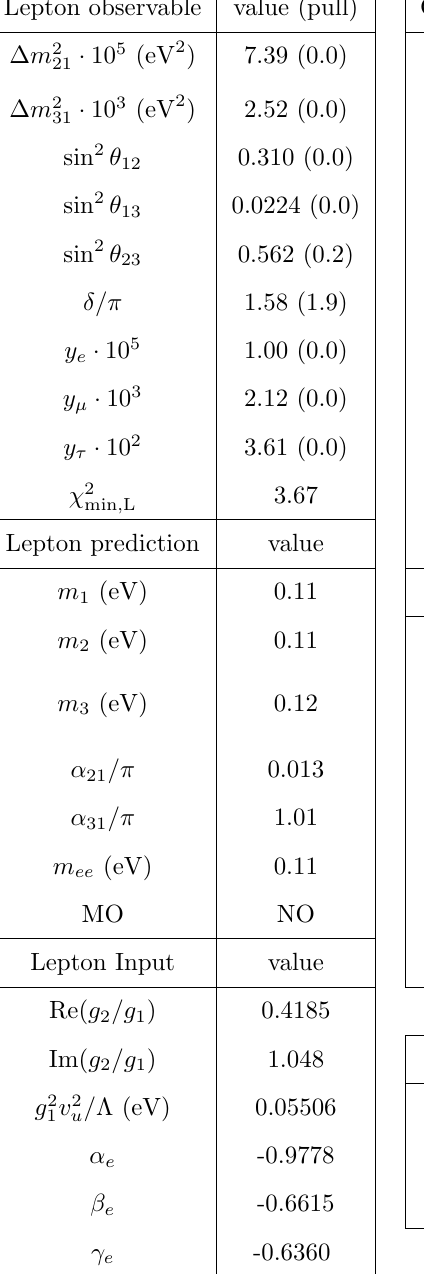
Table 5 . Results of the (cid:12)t to lepton and quark data for model combining M (cid:23) ; Y e ; Y V I In the left panel are the lepton observables and pulls (in fractions of 1 (cid:27) ), the (cid:31) 2 from the lepton sector, as well as predictions for neutrino masses, phases, neutrinoless double beta decay and mass ordering. The inputs for the lepton sector are displayed at the bottom. In the right panel we have the quark observables and pulls, the (cid:31) 2 At the bottom right we list the (cid:28) and (cid:30) inputs which are common to both sectors. We note